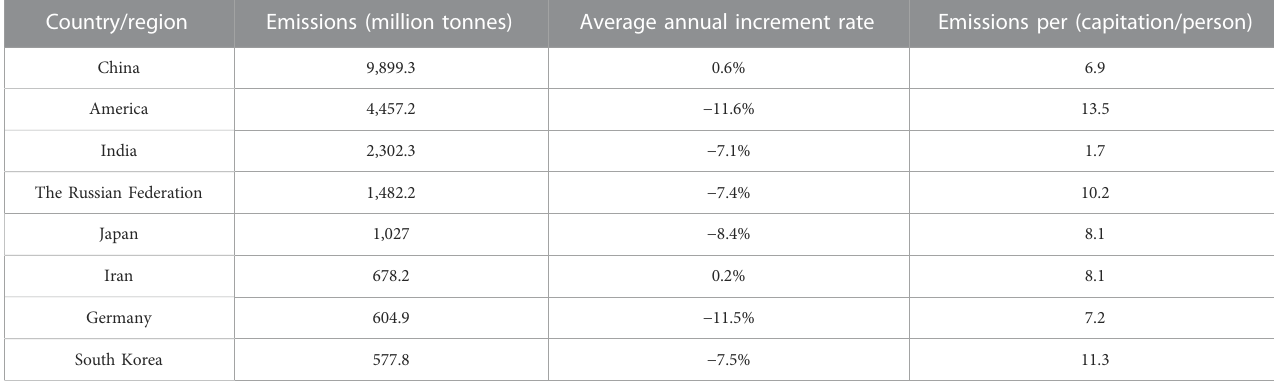
TABLE 2 Carbon dioxide emissions by countries in 2020.